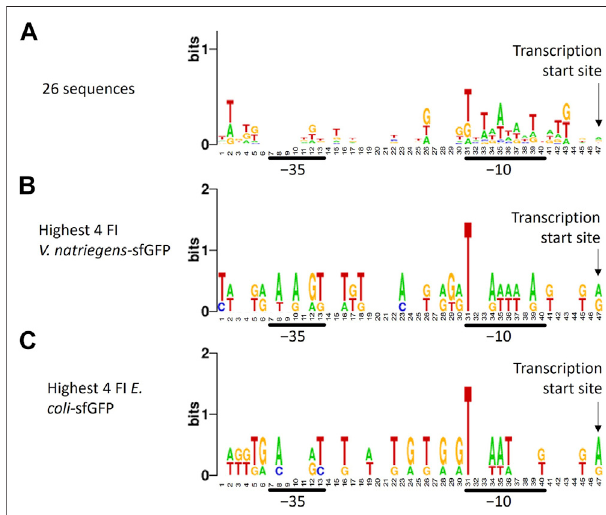
FIGURE 4 | Sequence logo created from trimmed aligned predicted promoter sequences. The sequence logo represents nucleotide biases in speci fi c positions by size. The taller the nucleotide, the more frequently the nucleotide appeared in that positions of the input sequences. Different alignments were made: (A) all 26 sequences, (B ) promoter sequences of the four V. natriegens clones with highest sfGFP FI (clones 23, 24, 25, 26), (C) promoter sequences of the four E. coli clones with highest sfGFP FI (clones 22, 23, 25, 26). The transcription start site, -10 and -35 regions are indicated. A minute nucleotide-position bias can be seen in the -10 region when all sequences are aligned (A) . Aligning sequences of clones with the highest sfGFP FI reveals a bias towards T in position 31, which is the -10 box start